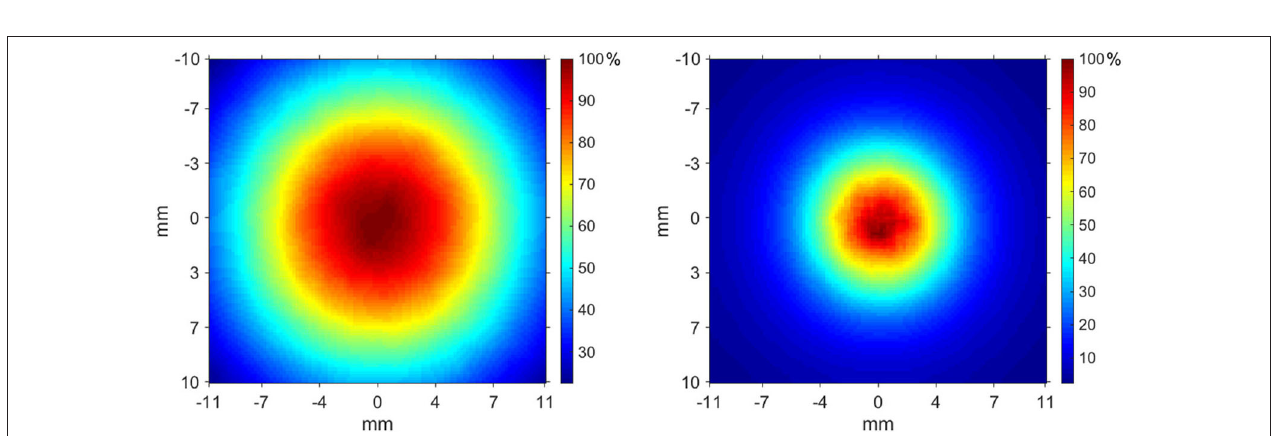
FIGURE 4 | Dose-response curve of EBT3 under conventional dose-rate irradiation with 6 MeV electrons in the range 0–20Gy. The fit curve is plotted as dotted line.